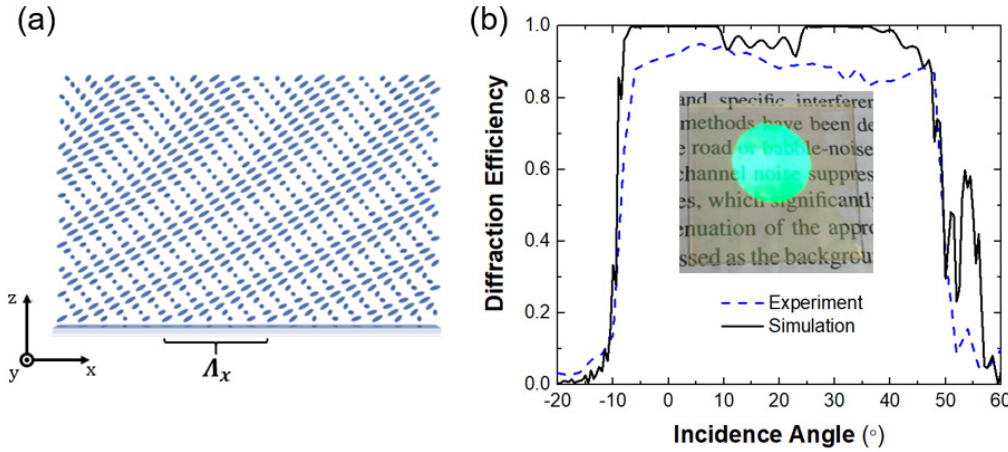
Figure 14. ( a ) Schematic diagram of gradient-pitch PVG. ( b ) Simulation and experimental results of angular response. Inset: photo of the sample.